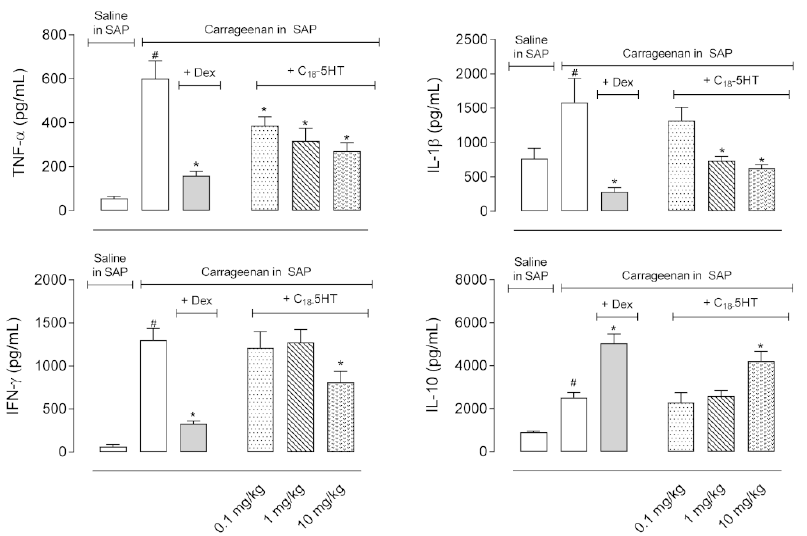
Figure 5. C 18 -5HT reduces cytokine production in the subcutaneous air pouch (SAP). The animals were pretreated with vehicle (tween 80, p.o.), C 18 -5HT (0.1, 1 or 10 mg/kg, p.o.), or dexamethasone (Dex, 2.5 mg/kg, i.p.) 60 min before carrageenan (1%) injection into SAP. Results are expressed as mean ± S.D. (n = 6–8). The statistical significance was calculated by ANOVA followed Newman’s post-test. # p < 0.05 when comparing the vehicle-treated group that received carrageenan in SAP with the vehicle-treated group that received saline in SAP and * p < 0.05 when comparing the dexamethasone or C 18 -5HT pretreated groups that received carrageenan in SAP with the vehicle- treated group that received carrageenan in SAP.